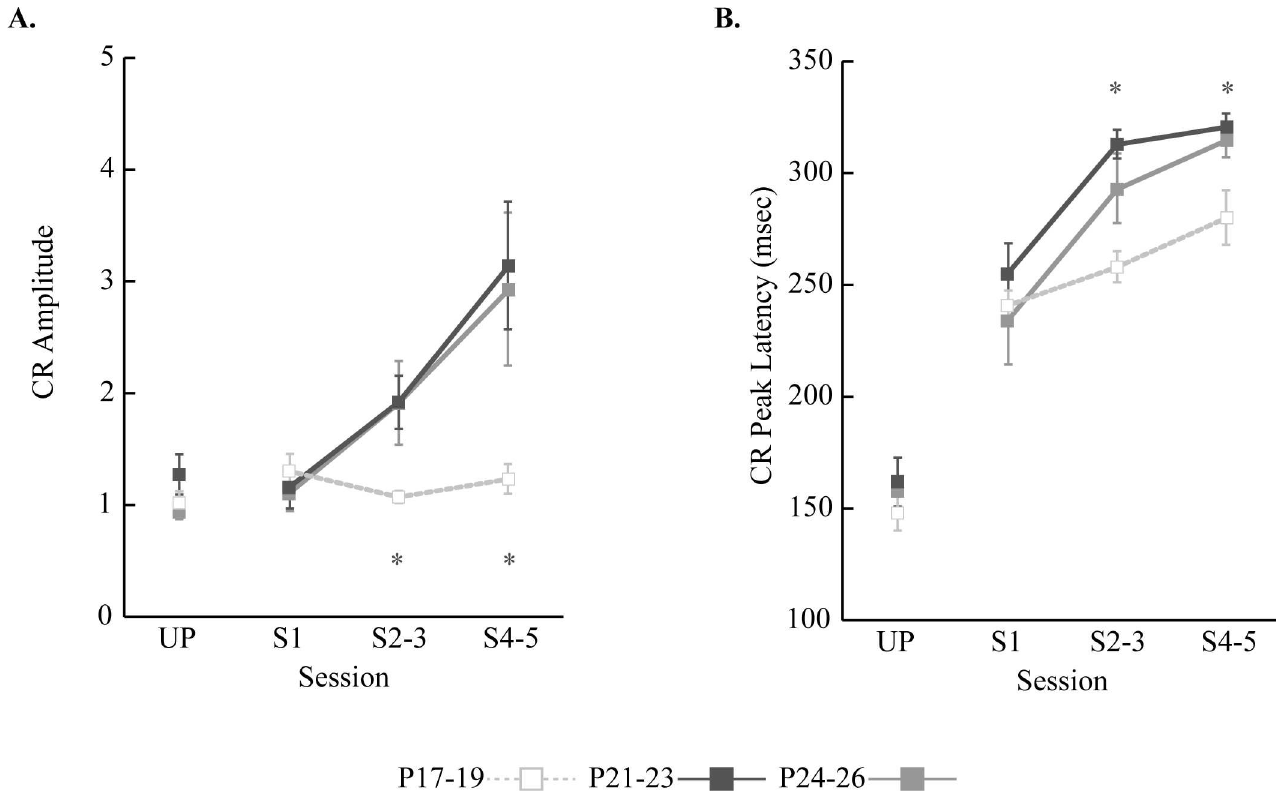
Fig 3. Mean (+/- SE) eyelid conditioned response (CR) amplitude and CR peak latency across the unpaired (UP) and paired sessions (S1-S5) for rat pups trained on postnatal days (P) 17–19, P21-23, or P24-26. A. Mean CR amplitude. The two oldest age groups showed greater increase in CR amplitudeacross paired sessions than the youngest age group. B. Mean CR peak latency. During UP, eyelid responsestended to occur 150 ms after the CR onset. However, as paired training progressed, CR peak latency was more alignedtoward the US onset in all age groups. The changes were more evident in the two older age groups than